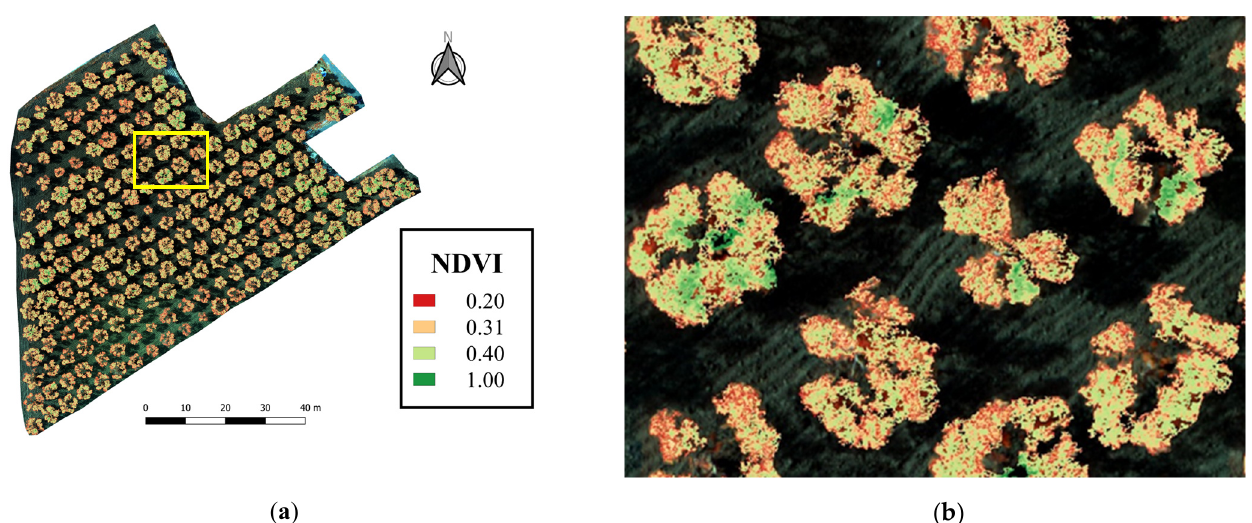
Figure 6. ( a ) NDVI for canopy and false background color image. ( b ) Zoom of canopy extracted for plant and corresponding NDVI.